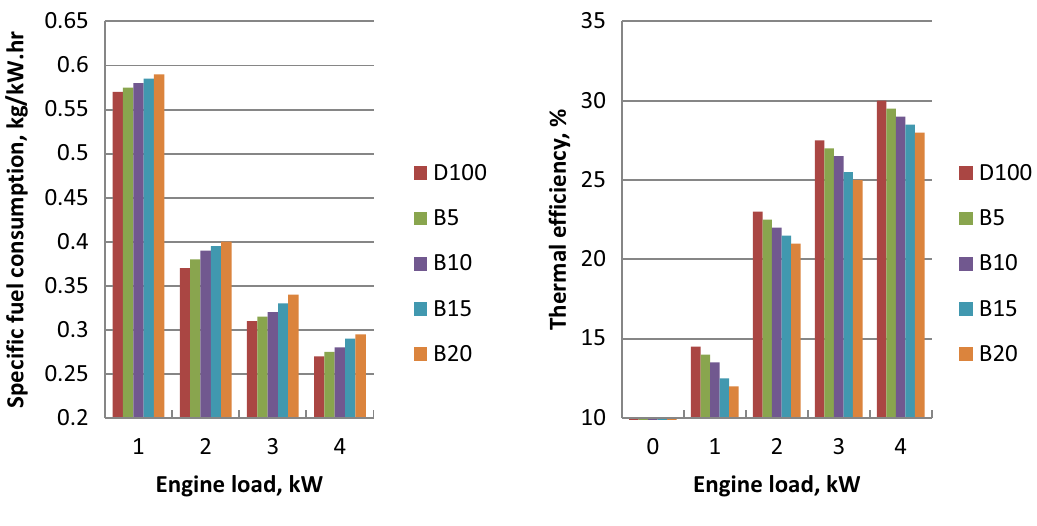
Figure 3. Values of BTE and BSFC against engine load for tested